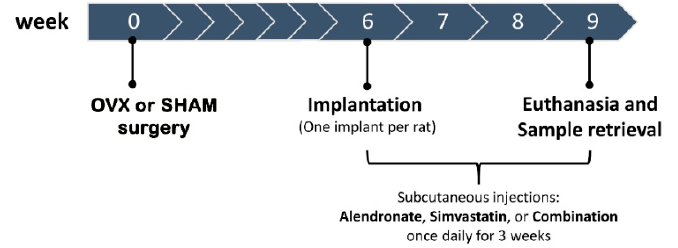
Figure 1. Schematic representation of study design and timetable.